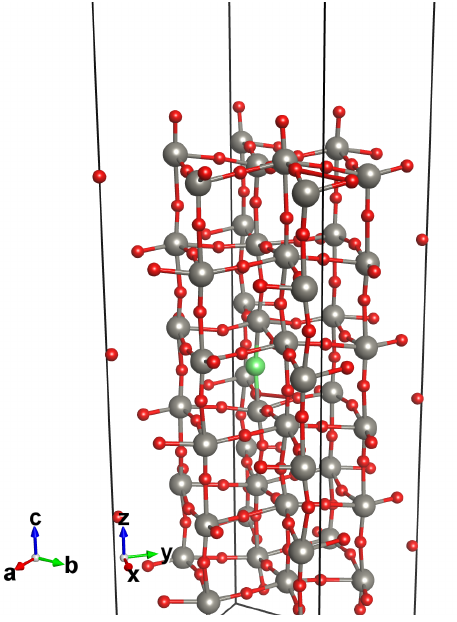
Figure 4. Atomic structure of the γ -monoclinic WO 3 (001) reconstructed surface. W in black and O in red; the bulk vacancy site is indicated in